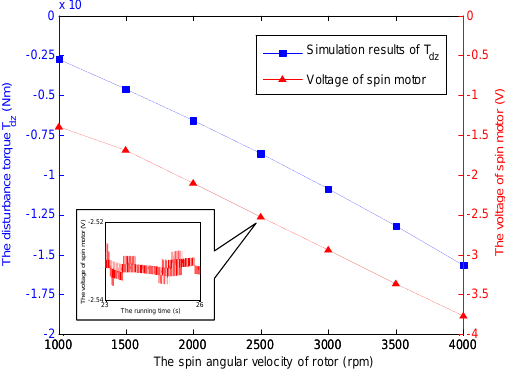
Figure 17. Comparison of T dz with varying angular velocities under φ x = 3 ◦ and φ y = 0 ◦